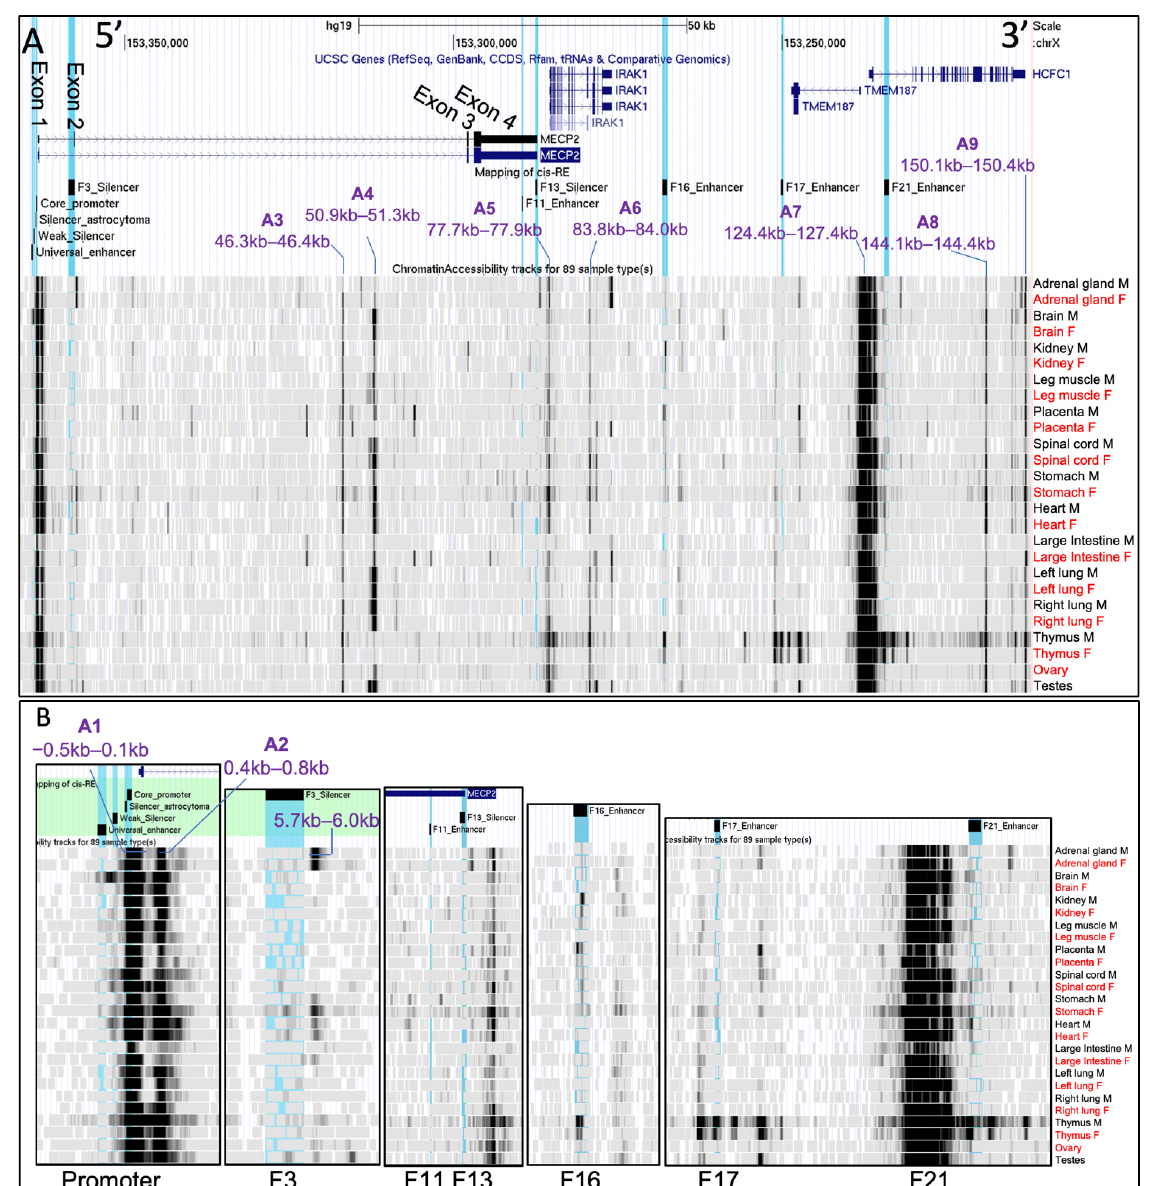
Figure 4. DNase-seq of different fetal tissues: males and females. ( A ) The chrX:153,212,176– 153,366,832 genomic region of hg19 human genome assembly is displayed in UCSC genome viewing browser. Direction is 5 ′ –3 ′ (sense orientation relative to the MECP2 ) gene. Tracks displayed from top to bottom: UCSC genes, mapping of previously identified [55] cis -REs (F3-F21) to genome, DNase-seq data tracks. Cis -REs were highlighted in blue in UCSC. Scale on top represents distance equivalent to 50 kb. MECP2 exons are labeled on UCSC Genes data track. Genomic segments with consistently high chromatin accessibility (darker regions) are labeled A1–A9. The distances are relative to the first nucleotide of the MECP2 exon 1 (hg19 chrX:153,363,188). Labels are copied and added to the left for easier reference. Labels consist of a tissue type followed by M (male) or F (female). Darker areas represent more mapping reads binding to that specific genomic region, hence higher chromatin accessibility. ( B ) Zoomed in portion of the genomes focused on the MECP2 promoter and cis -REs. Cis -REs are labeled inside and on the top of each box. Labels are the same as in pane A. DNase- seq data included data tracks from various donors of 85 to 127 days old during the fetal stage of development from data series